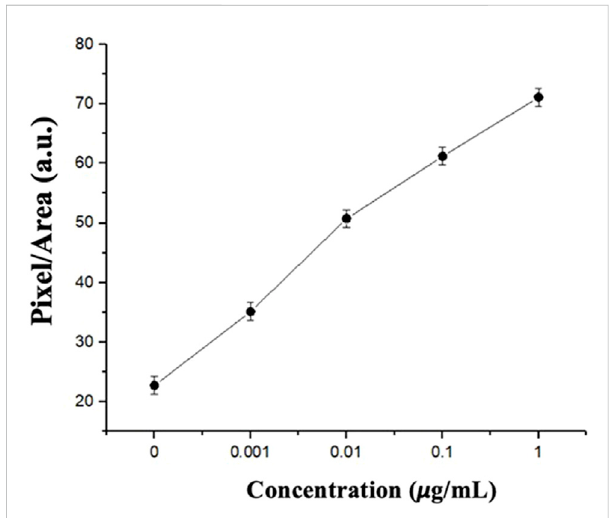
FIGURE 11 Pixel/area vs. concentrations based on the confusion